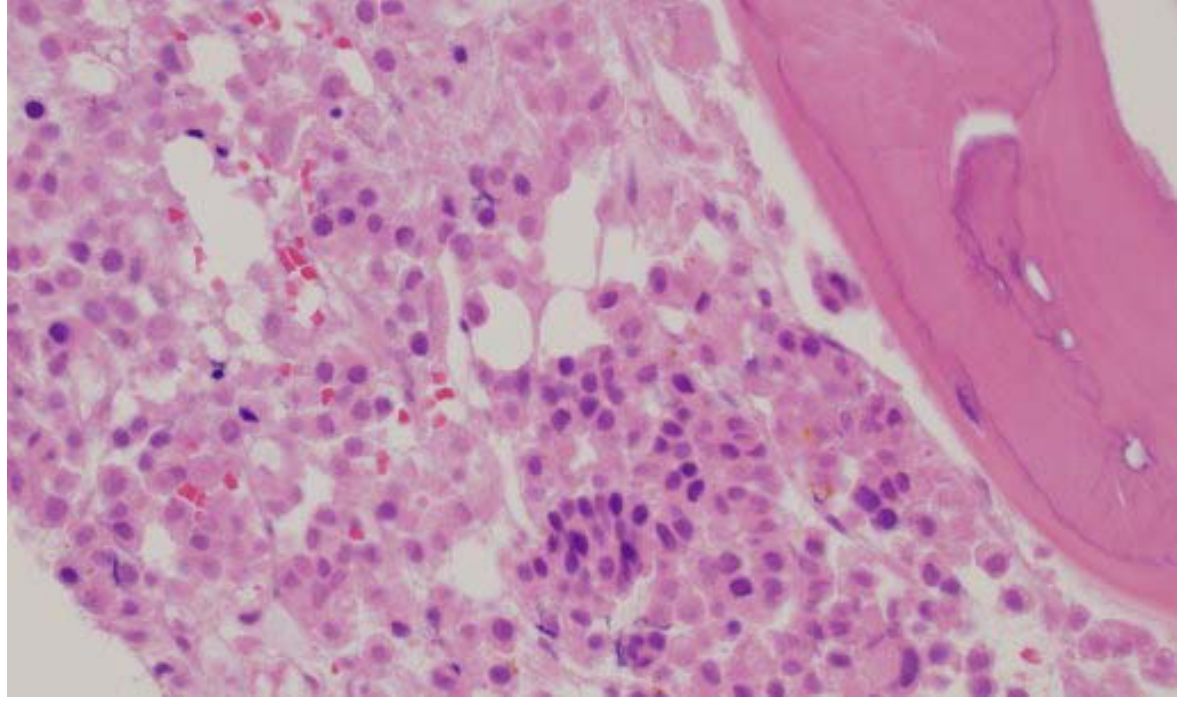
FIGURE 1 . Bone marrow biopsy. H&E stain shows complete replacement of the bone marrow cavity with metastatic urothelial tumor cells, fibrosis, and tumor